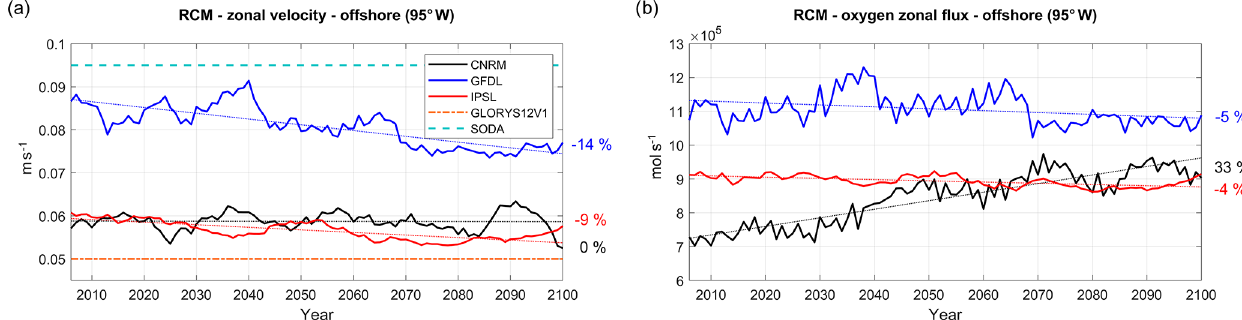
Figure 9. (a) zonal velocity (ms − 1 ) and (b) oxygen zonal flux (mols − 1 ) in the eastern equatorial Pacific at 95 ◦ W, averaged between 2 ◦ N and 10 ◦ S and between 50 and 200m, for the three RCMs (CNRM in black, GFDL in blue, IPSL in red). The time series are filtered using a 10-year moving average. Mean values from GLORYS12V1 and SODA reanalyses are marked in (a) by a dashed–dotted orange line and a dashed cyan line,